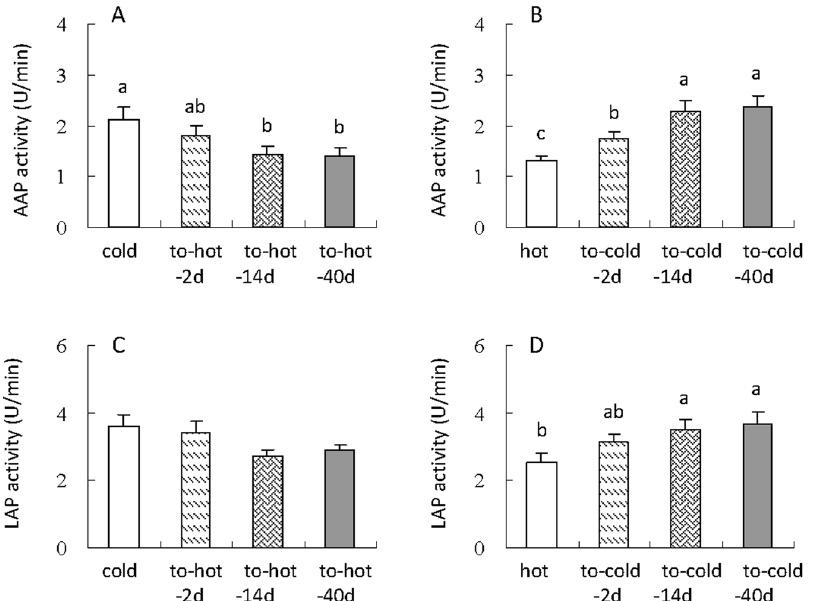
Figure 6. AAP activity (A, B) and LAP activity (C, D) of striped hamsters during the transition of cold to hot or hot to cold condition. Different letters (a, b or c) above the columns indicate significant difference between the four groups under same temperature ( P , 0.05). Data are